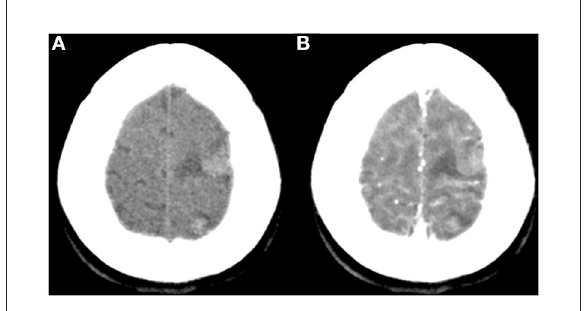
FIGURE1 Non-contrast (A) and contrast-enhanced CT (B) showed multiple rounded lesions with mild inner enhancement in the left frontal and parietal areas.